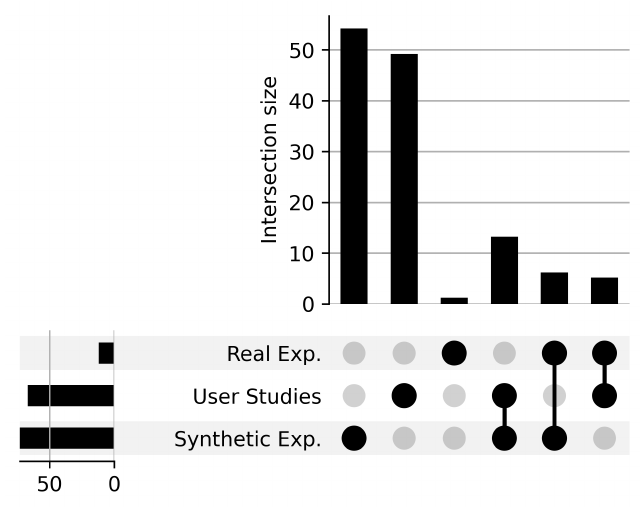
Figure 13. UpSet plot presenting the distribution of different methods of evaluating the explainable systems. The vertical bars in the bottom-left represents the number of studies conducting each of the methods. The single and connected black circles represents the combination of the evaluation methods and the horizontal bars illustrate their number of